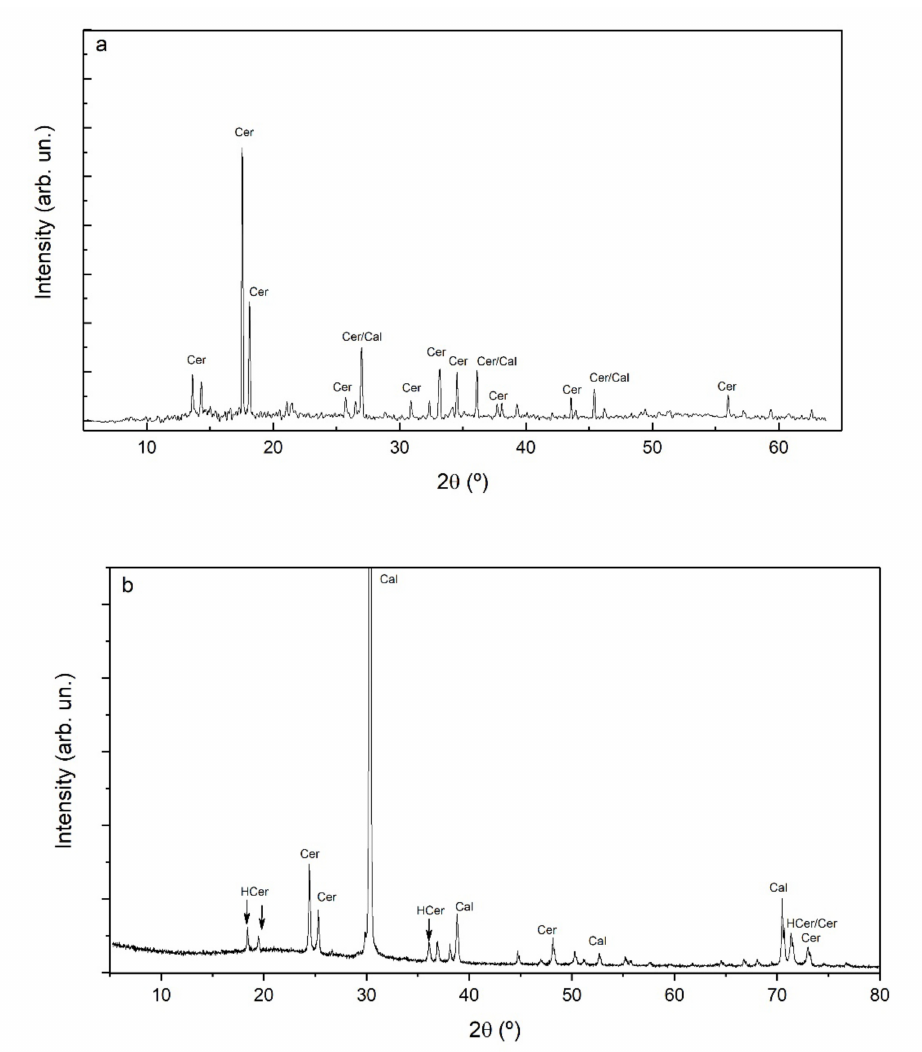
Figure 8. X-ray powder diffraction pattern of precipitates formed on calcite interacting with Pb-bearing solutions. ( a ) The main reflections of cerussite (Cer) are identified when the reaction takes places with a solution with [Pb] i = 1 mM. ( b ) Reflections that match well with hydrocerussite (HCer) and cerussite (Cer) are identified in precipitates formed during the interaction between calcite with solutions with [Pb] i = 10